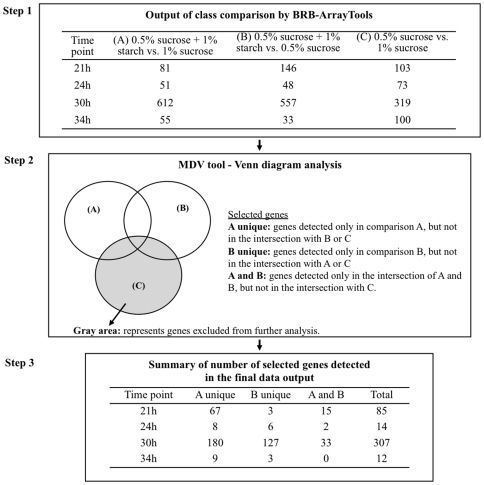
Schematic illustration of the microarray data analysis using BRB-ArrayTools in conjunction with MDV software.Step 1: represent the number of genes detected as differentially expressed in each condition and time point evaluated (see Data S1 ). Step 2: Microarray Data Visualizer (MDV) using the Venn diagram to select genes of interest. Step 3: genes selected according to MDV analysis and cutoff of fold of change in gene expression (fold ≥1.8 and ≤0.6; see Data S2).